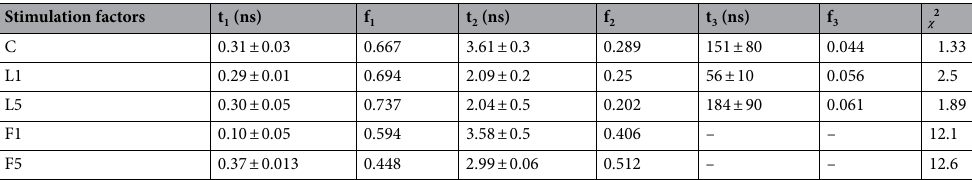
Table 3. Fluorescence lifetimes (t) and corresponding fractional intensities (f) in the analyzed alfalfa leaves. C control (unstimulated seeds), L1, L5 He–Ne laser light stimulation with 1 and 5 min exposure, respectively, F1, F5 alternating magnetic field stimulation with 1 and 5 min exposure, respectively.